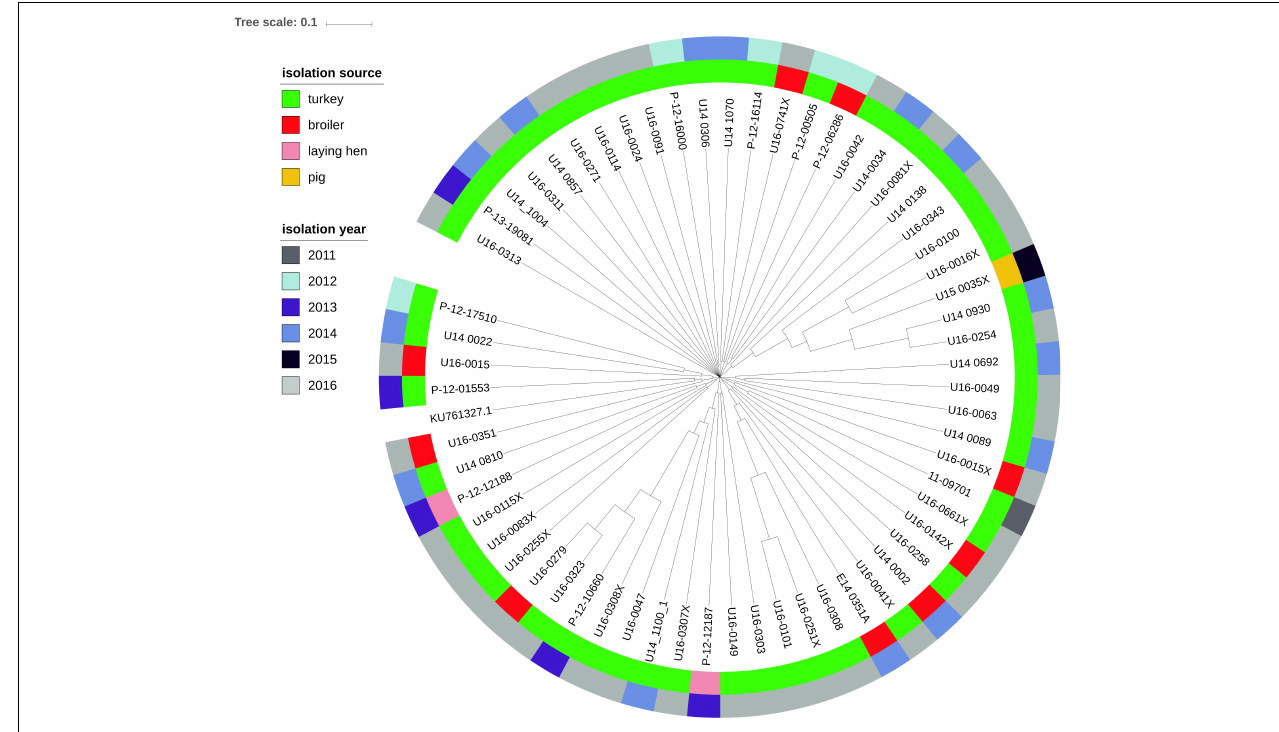
FIGURE 8 | Phylogenetic relationship of contigs with mcr-1 and IncX4 plasmid replicon extracted from the genomes of 61 E. coli isolates by source and year of E. coli isolation. Complete sequence of IncX4 plasmid with accession number KU761327.1 from GenBank was used as the